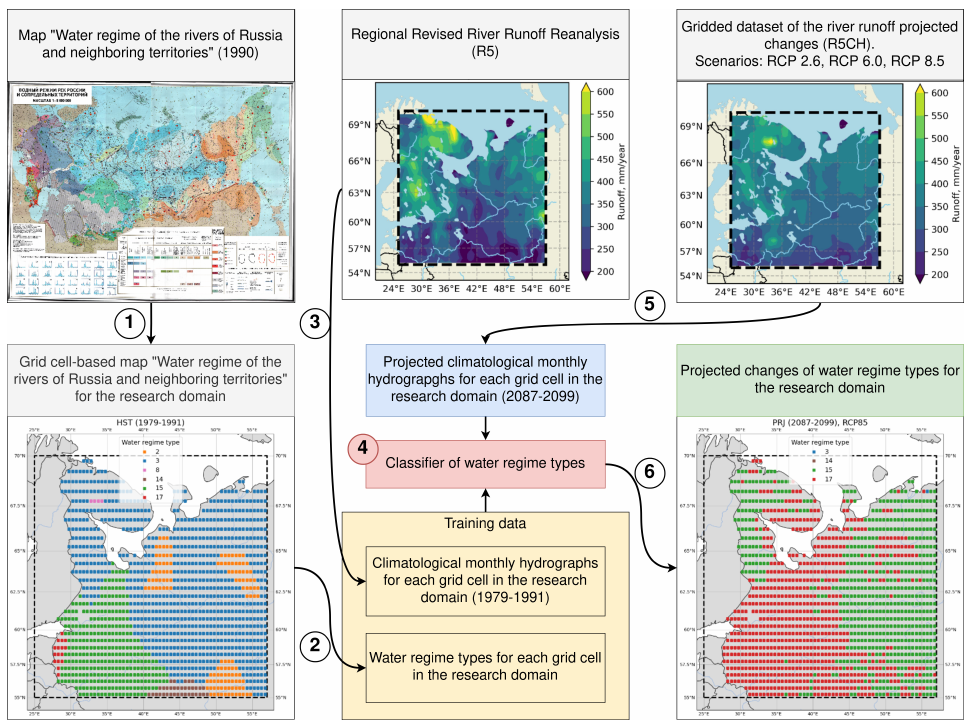
Figure 3. Illustration of the proposed computational workflow. Numbers in circles represent consec- utive computational steps.